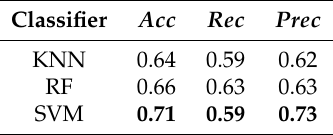
Table 3. Investigation of H1: Classification performance obtained when classifying PPG features with K-Nearest Neighbor (KNN), Random Forest (RF) and Support Vector Machine (SVM) classifiers. Classification accuracy ( Acc ), recall ( Rec ) and precision ( Prec ) are reported.